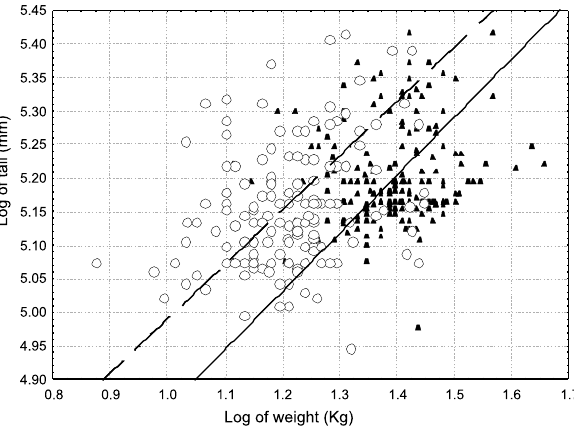
Figure 3. Tail length against mass (log transformed) for male and e female Coscoroba swans. Scaling lines are plotted for both sexes using RMA regression (female: y = 4.11+0.87*x, males: y = 4.07+0.811*x). The slopes were not significantly different, but el- evation was significantly greater for females (p < 0.001, Table III). ( (cid:99) ) Females, ( (cid:83) )